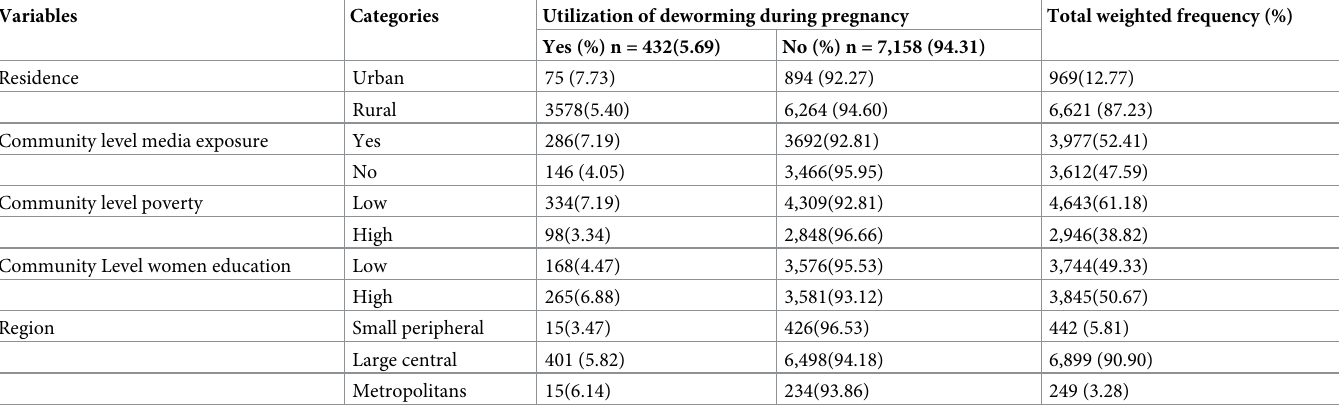
Table 2. Community-level variables for utilization of deworming among pregnant women, EDHS 2016.